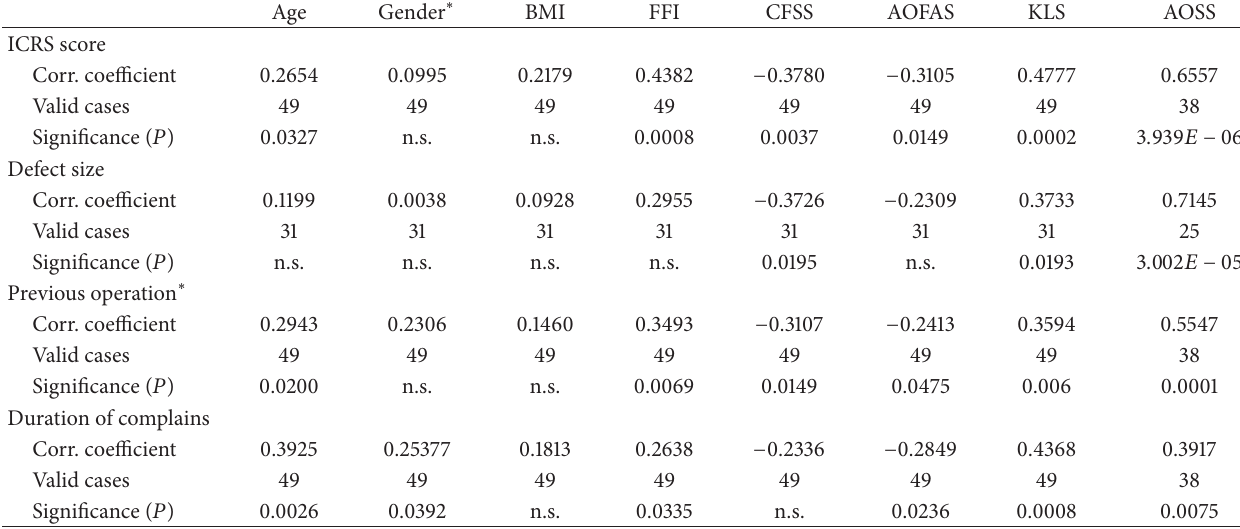
Table 1: Correlation of items characterizing a cartilage lesion in the ankle with epidemiological data, function, and radiological